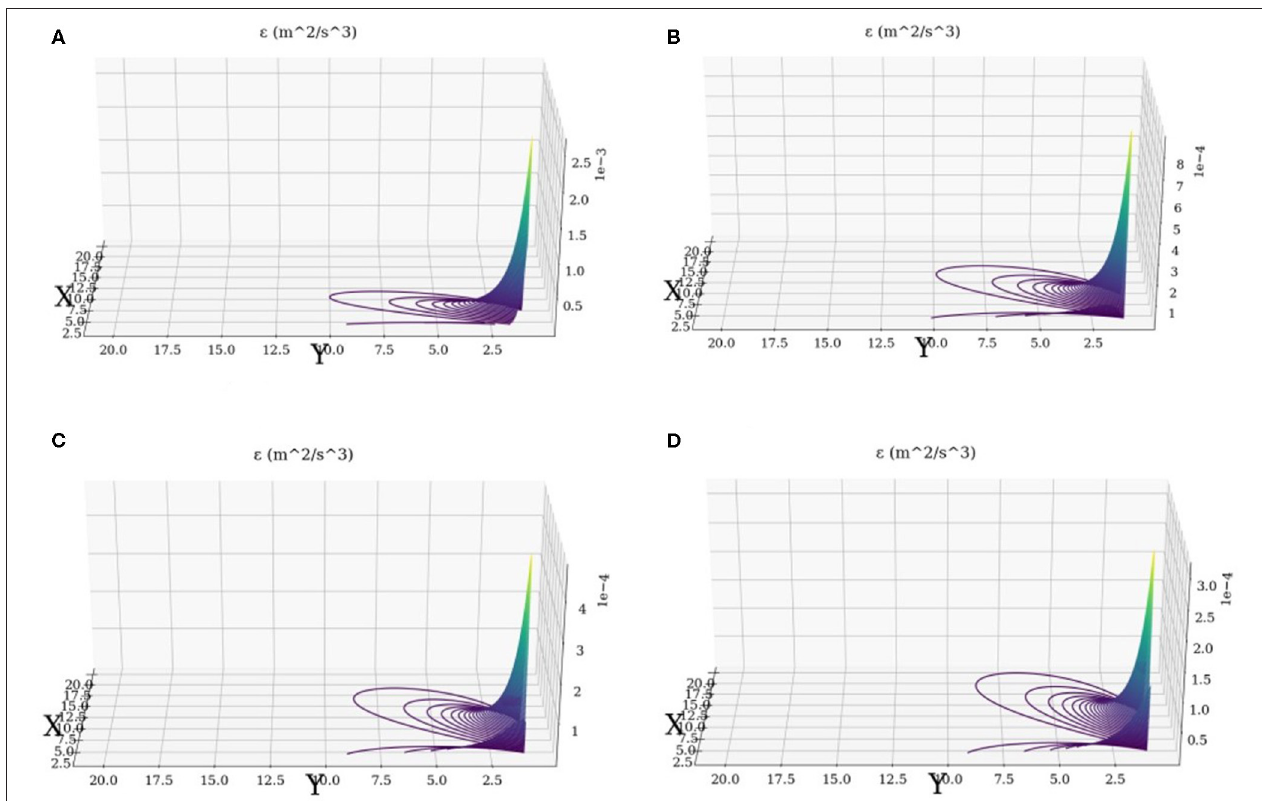
FIGURE 4 | Turbulent dissipation rate field ε , for θ